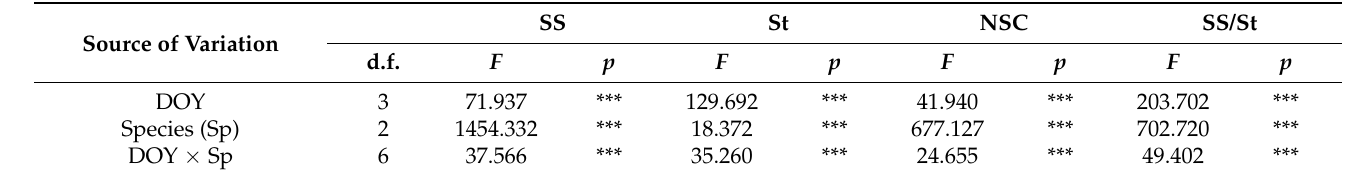
Table 2. Results of two-way repeated measures ANOVA ( F and p -values) on the effect of day of year (DOY), Species (Sp) and interaction between DOY and Species (DOY x Sp) on the total soluble sugars (SS), starch (St), non-structural carbohydrates (NSC), and SS/St ratio. *** p < 0.001. SS St NSC Source of Variation